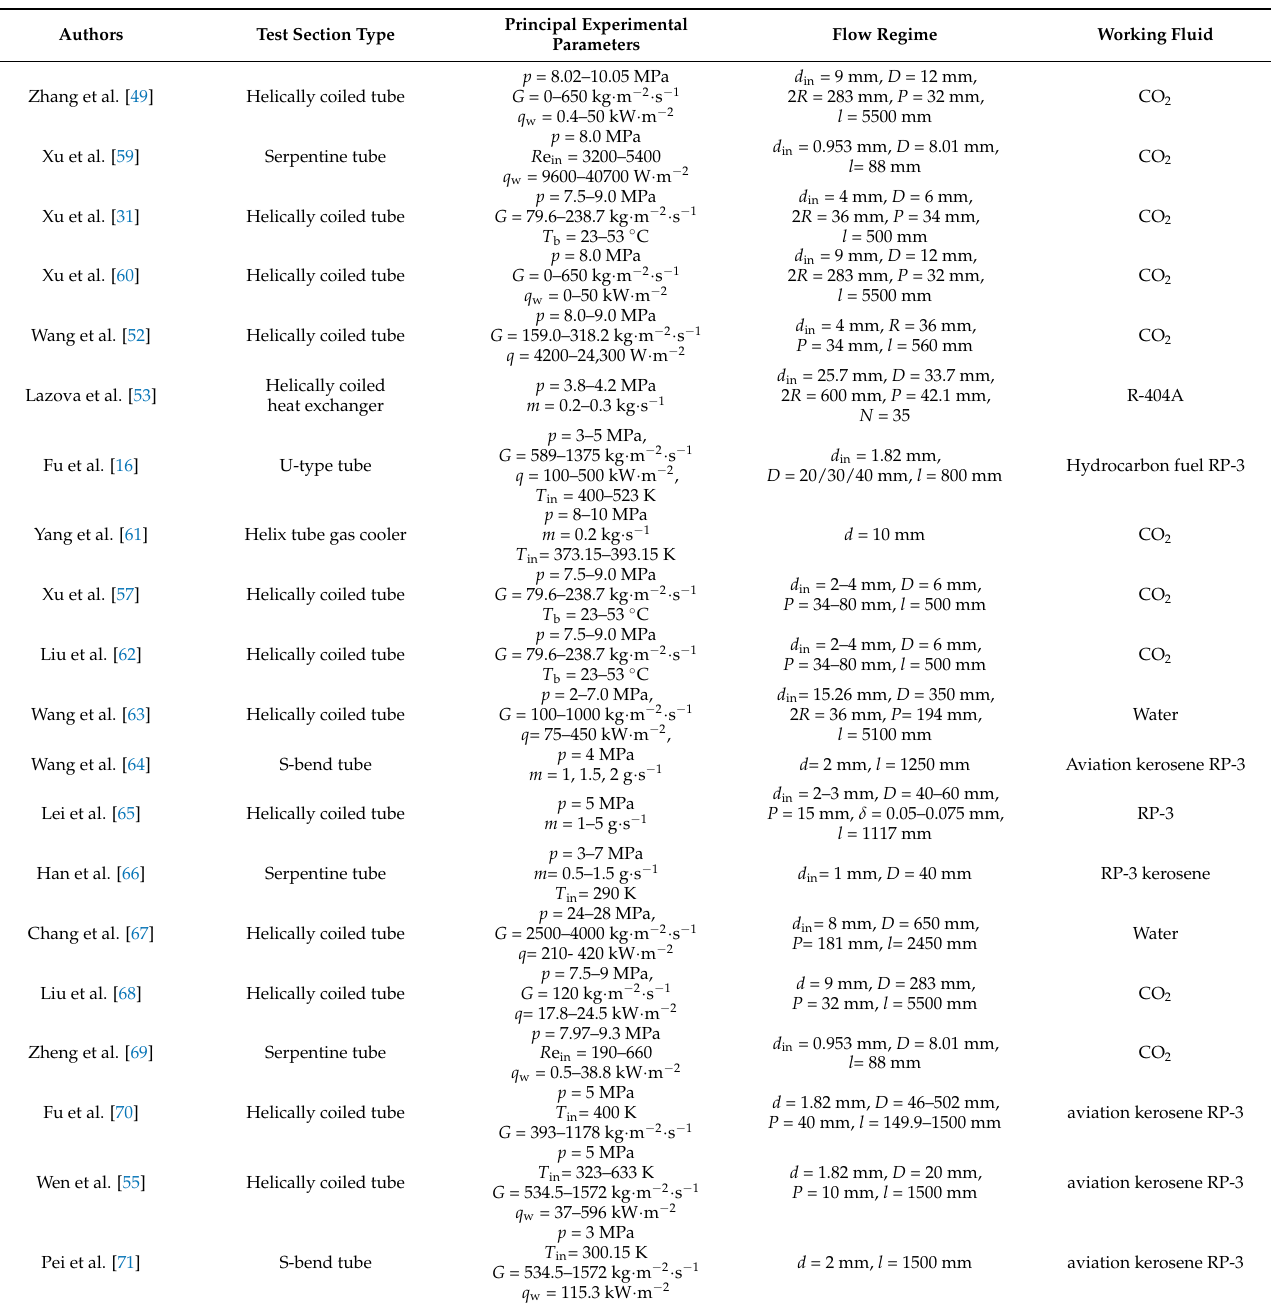
Table 1. Summary of the available experimental studies on heat transfer characteristics of supercritical fluids in curved